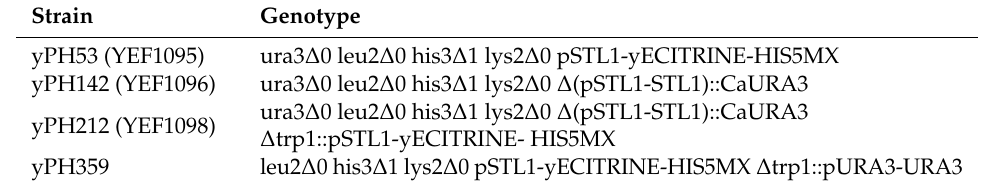
Table A1. Strain genotypes.